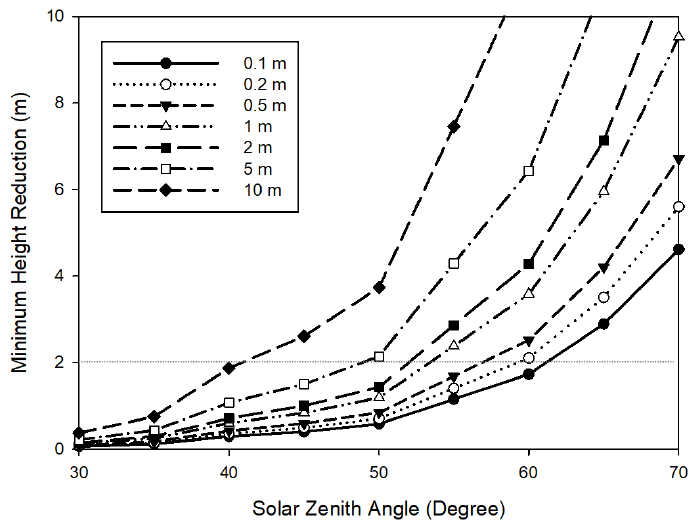
Figure 5. The estimated detection error as the detectable minimum height reduction ( ∆ H min ) related to the image spatial resolution and solar elevation angle.